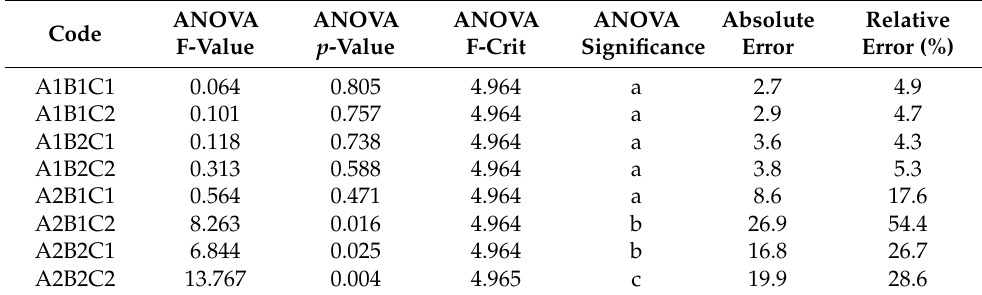
Table 6. ANOVA and error analysis of